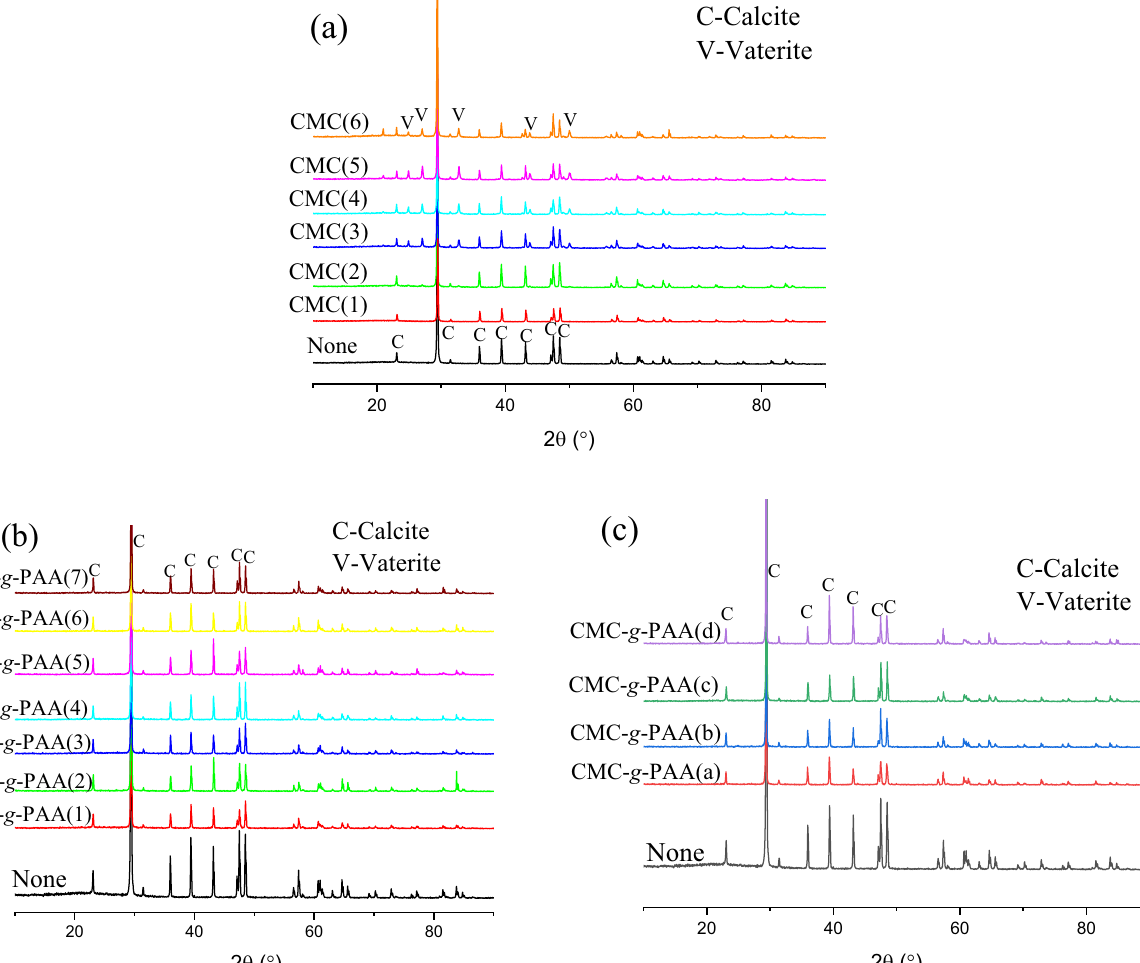
Figure 5. The XRD patterns of CaCO 3 prepared from CaCl 2 and NaHCO 3 aqueous mixtures ( a ) in the presence of various CMC samples with different degrees of carboxyl substitution: CMC(1)–CMC(6), ( b ) in the presence of various CMC- g -PAA samples with different grafting ratios: CMC- g -PAA(1)–CMC- g -PAA(7), and ( c ) in the presence of various CMC- g -PAA samples with different grafted-chain distributions: CMC- g -PAA(a)–CMC- g -PAA(d). The black line in ( a ), ( b ) and ( c ) presents the XRD pattern of CaCO 3 prepared from CaCl 2 and